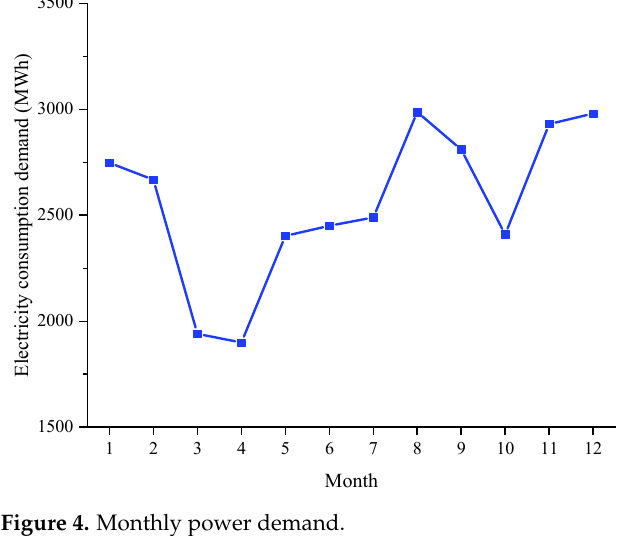
Figure 4. Monthly power demand.